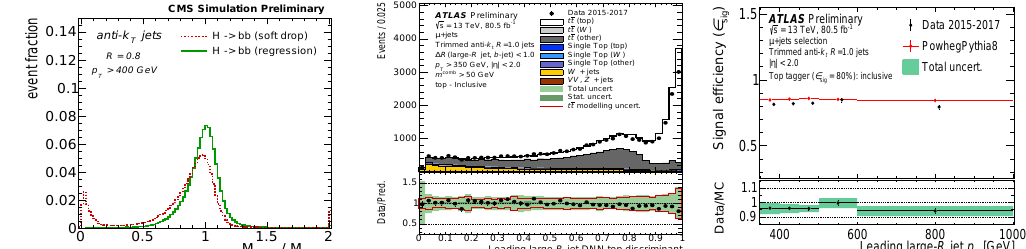
Figure 2: Performance of the ParticleNet regression (solid) and the soft drop algo- rithm (dashed) [ 13 ] . The mass response is shown for 100 < M H → bb jet compositions (left). Distribution of the DNN score for the leading large-R jets in top-enhanced single-muon t ¯ t events (middle). The measured efficiencies for the 80% for inclusive top taggers (right) [ 20 ]